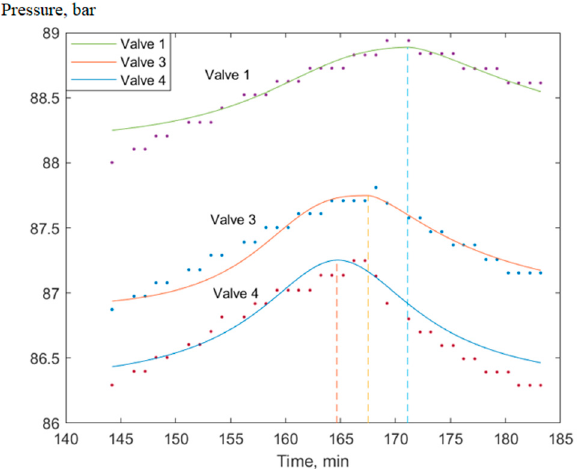
Figure 5. Approximation of curves p i ( t ) (valves 1, 3, and 4). Compression waves. Example 3.